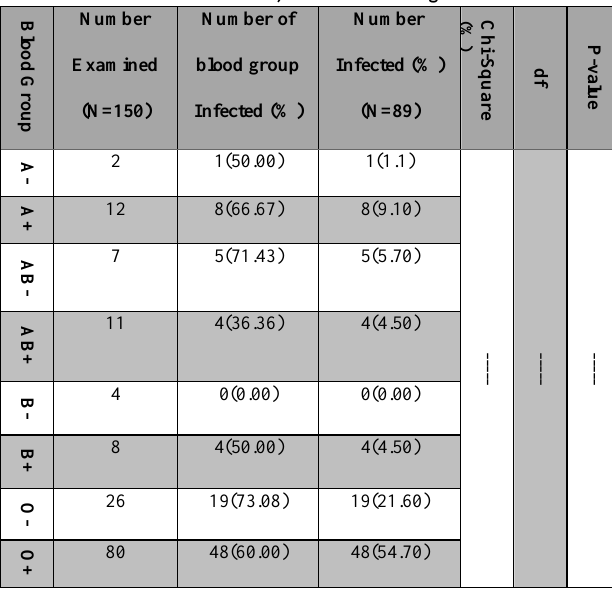
Table 3. Prevalence of malaria in relation to blood group among gravid women attending antenatal clinic at two Maternity Centres in Atani, Anambra State, South-eastern Nigeria.